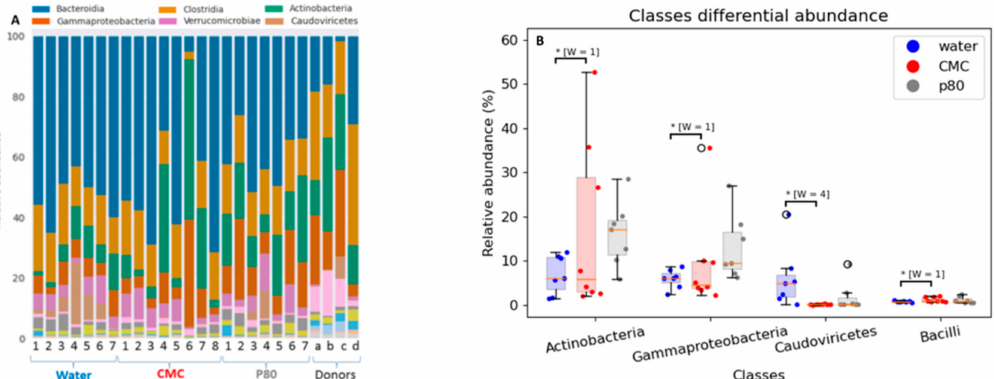
Figure 6. The effect of the CMC (1% w / v , red), P80 (1% v / v , gray), and water (control, blue) on cecal microbiota composition (in percent) ( A ) and the relative abundance of top four phyla ( B ), at the class levels analyzed via whole genome (shotgun metagenomics) sequencing in humanized IL10 − / − mice after 28 days exposure. Lowercase letters are IBD donors and d is a pooled fecal of a, b, and c. Data are the means ± SEM ( n = 7–8). * [W = X] indicates differential abundance by ANCOM with Holm–Bonferroni multiple-testing